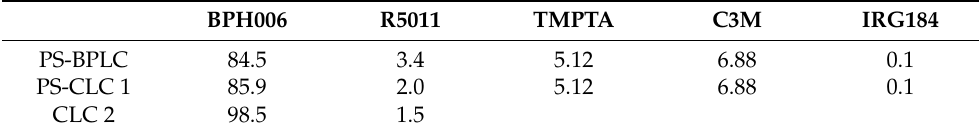
Table 2. Composition ratio of three-wavelength LC filter (wt %).